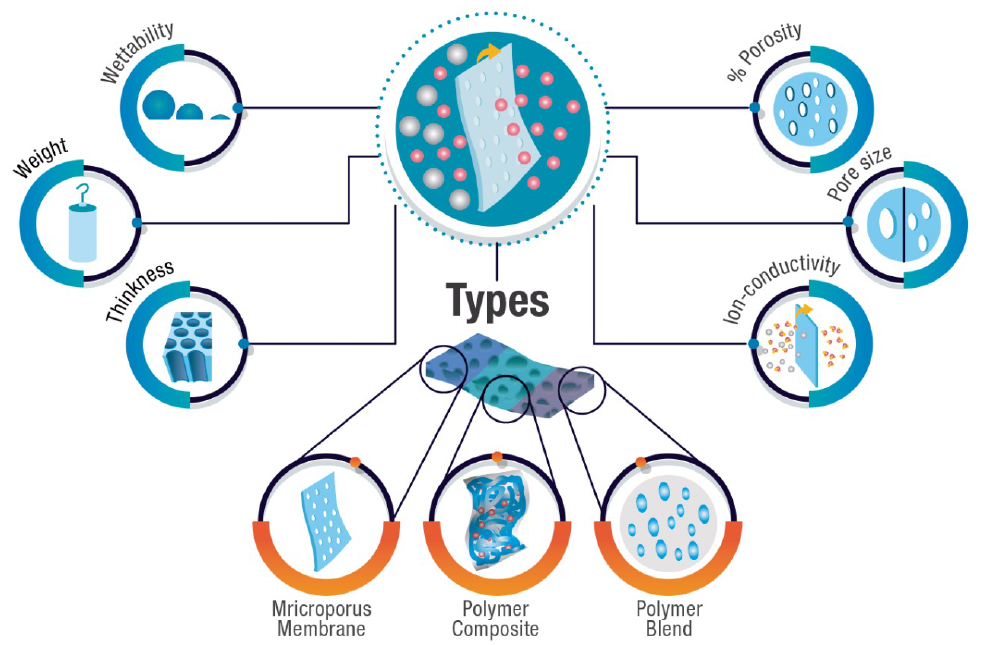
Figure 12. Critical characteristics of separator materials and their general classification. Graph constructed by the